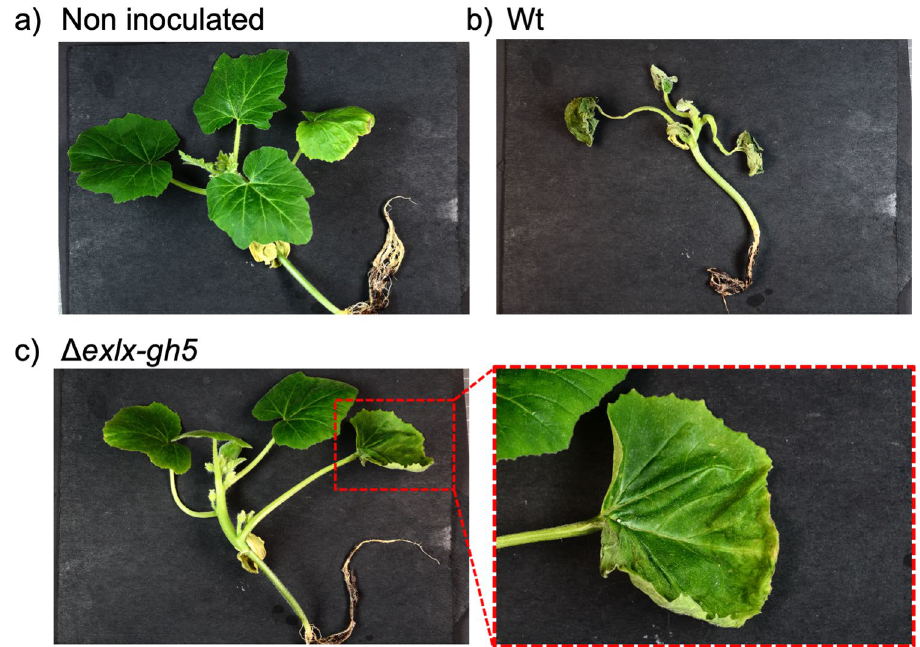
Figure 5. Visual comparison of wilt symptoms in squash seedlings after inoculation with either the Δ exlx–gh5 mutant or wild type Erwinia tracheiphila . ( a ) Non-inoculated squash seedling with no wilt symptoms ( b ) Squash seedling inoculated with wild type E. tracheiphila that has developed systemic wilt symptoms ( c ) Representative symptoms caused by inoculation with the Δ exlx–gh5 mutant strain, where wilt often remains localized to the inoculated leaf without causing systemic wilt symptoms.